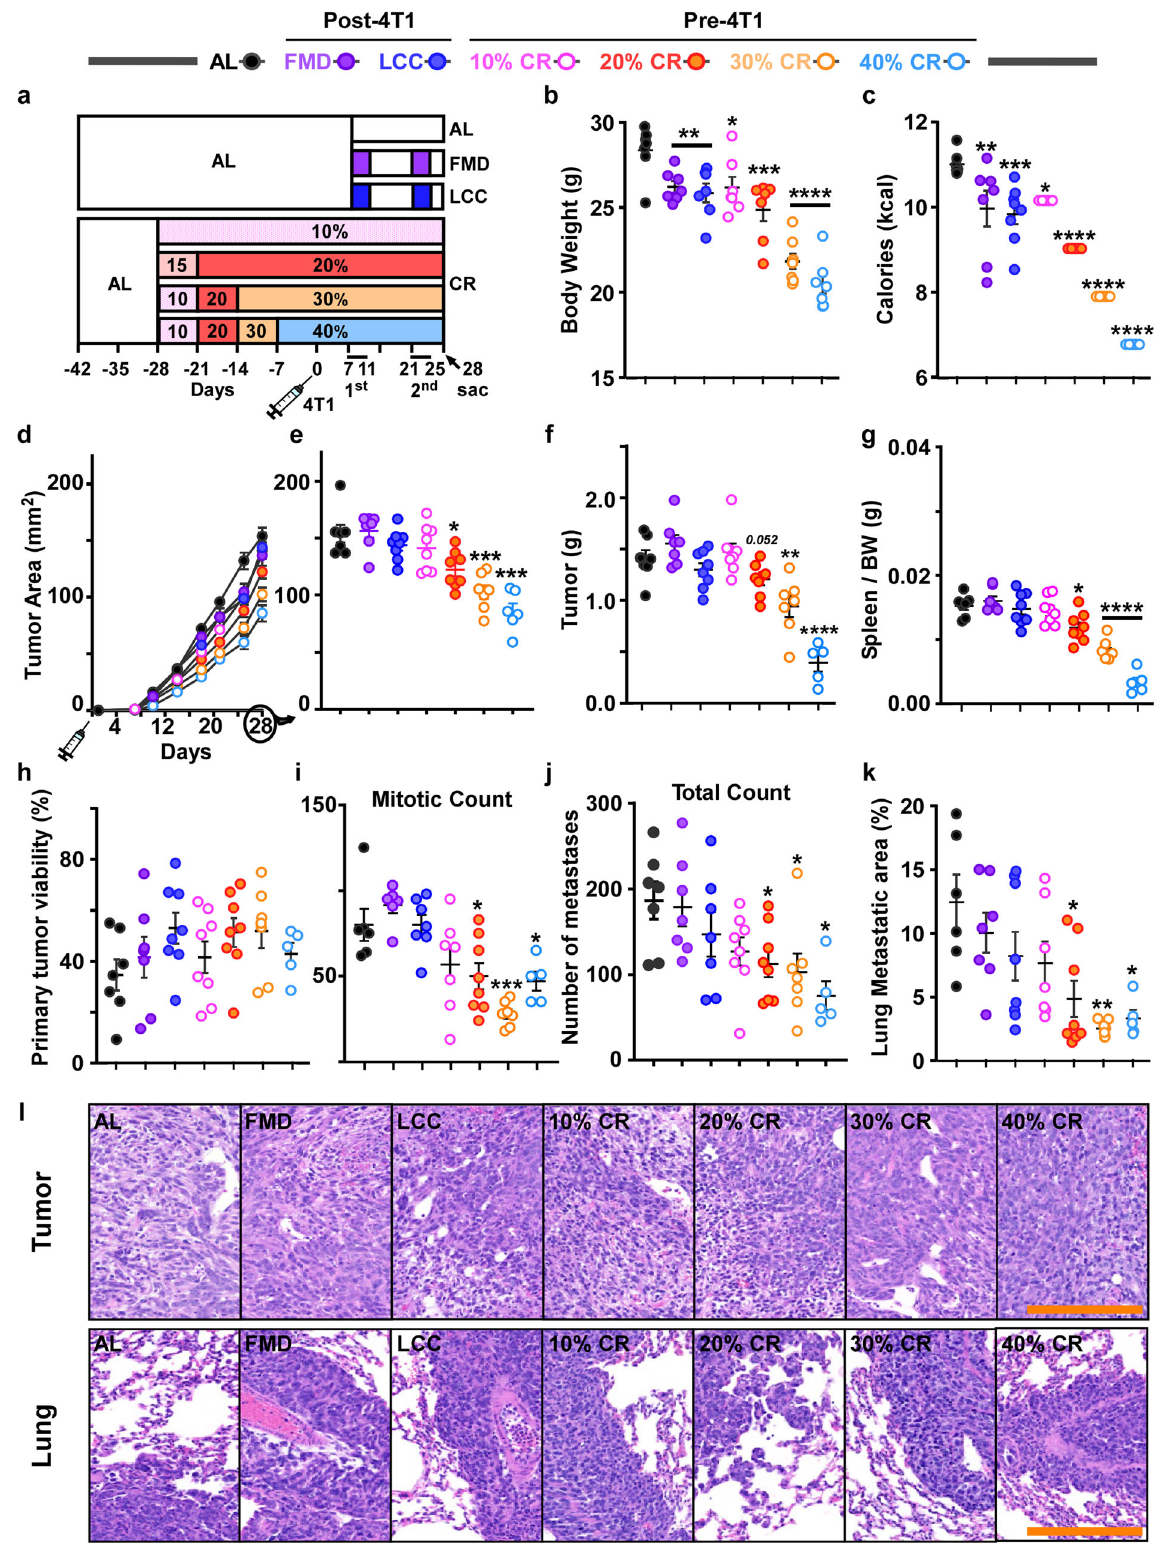
two important factors for improved breast cancer survivorship 50 . Consistent with prior fi ndings in the 4T1 cancer model 51 , we did not fi nd signi fi cant differences in CD4 + or CD8 + TILs levels within the TME (Fig. 7g, h, and Supplementary Fig. 10e), which may be indicative of the diverse array of mature and differentiated cells within this population 52